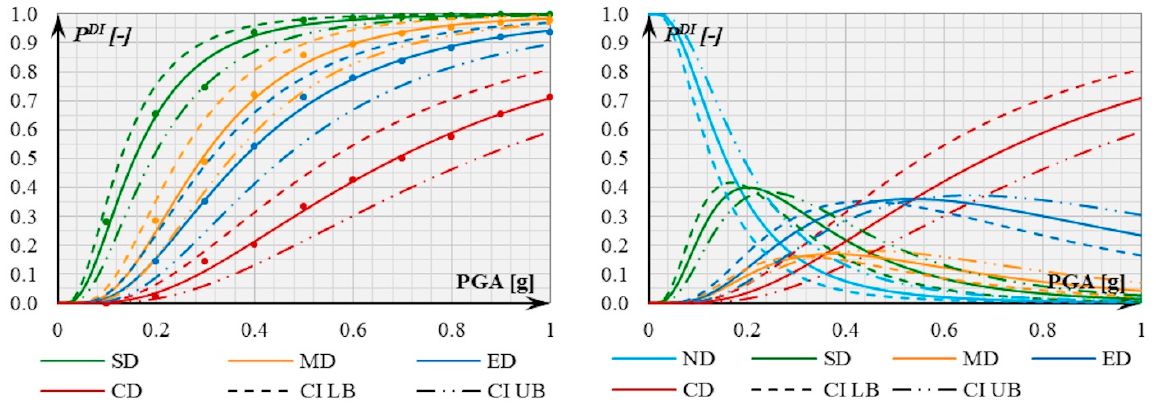
Figure 20. Fragility curves and probability density functions for the occurrence of different states of damage, according to the modified Park and Ang DI [34].